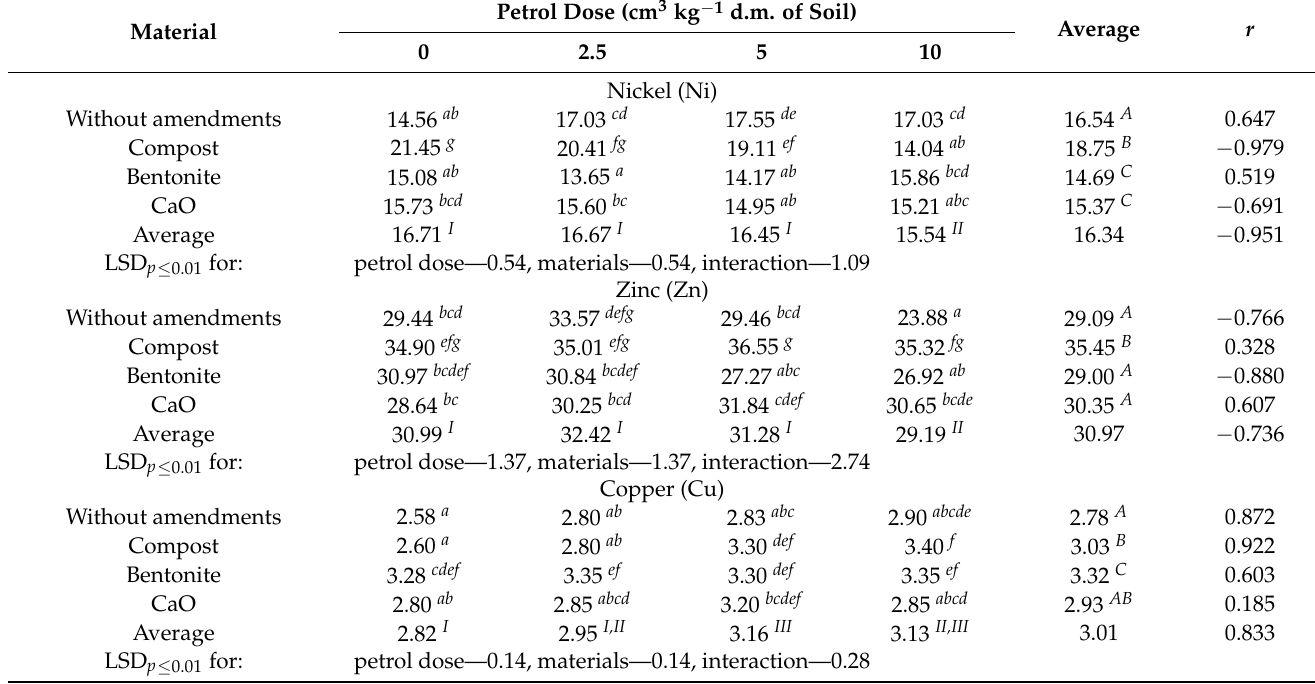
Table 2. The content of nickel, zinc, and copper in the soil (mg kg − 1 d.m.).